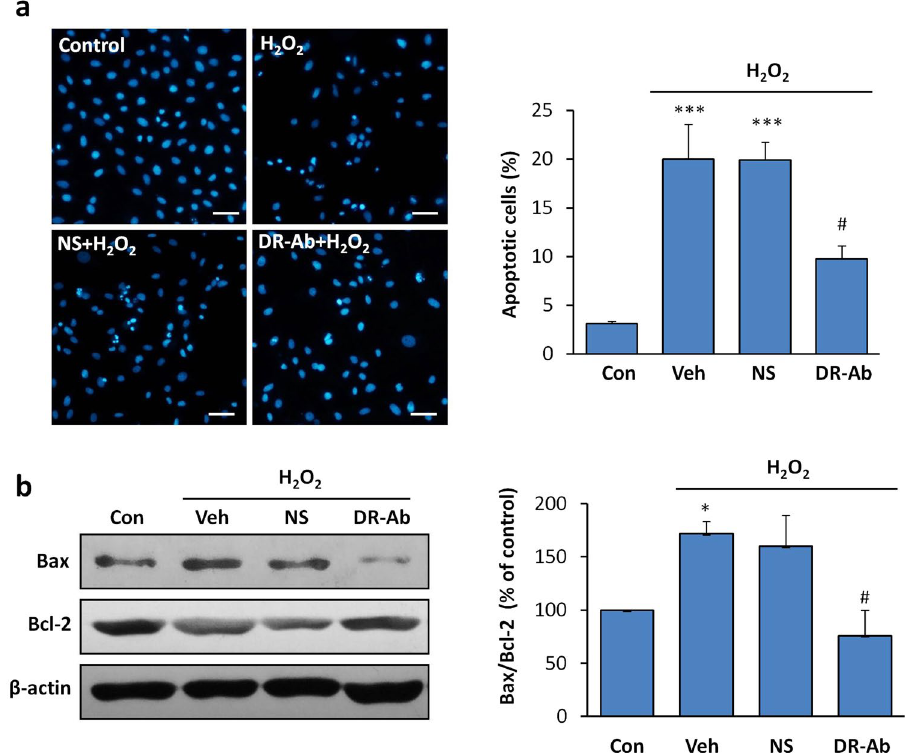
Figure 5. Effect of DR-Ab on H 2 O 2 -induced apoptosis in H9C2 cells. ( a ) DR-Ab reduced the number of apoptotic cells induced by overnight incubation with 100 μ M H 2 O 2 , as measured by the condensed and bright nuclei in Hoechst33342 staining. From 3 independent experiments; ( b ) Representative Western blots and group analysis showing protein expression of Bcl-2, Bax. n = 4. Mean ± SEM. * p < 0.05, *** p < 0.001 vs control, # p < 0.05, vs corresponding NS group. NS: Rat normal antibody, as negative